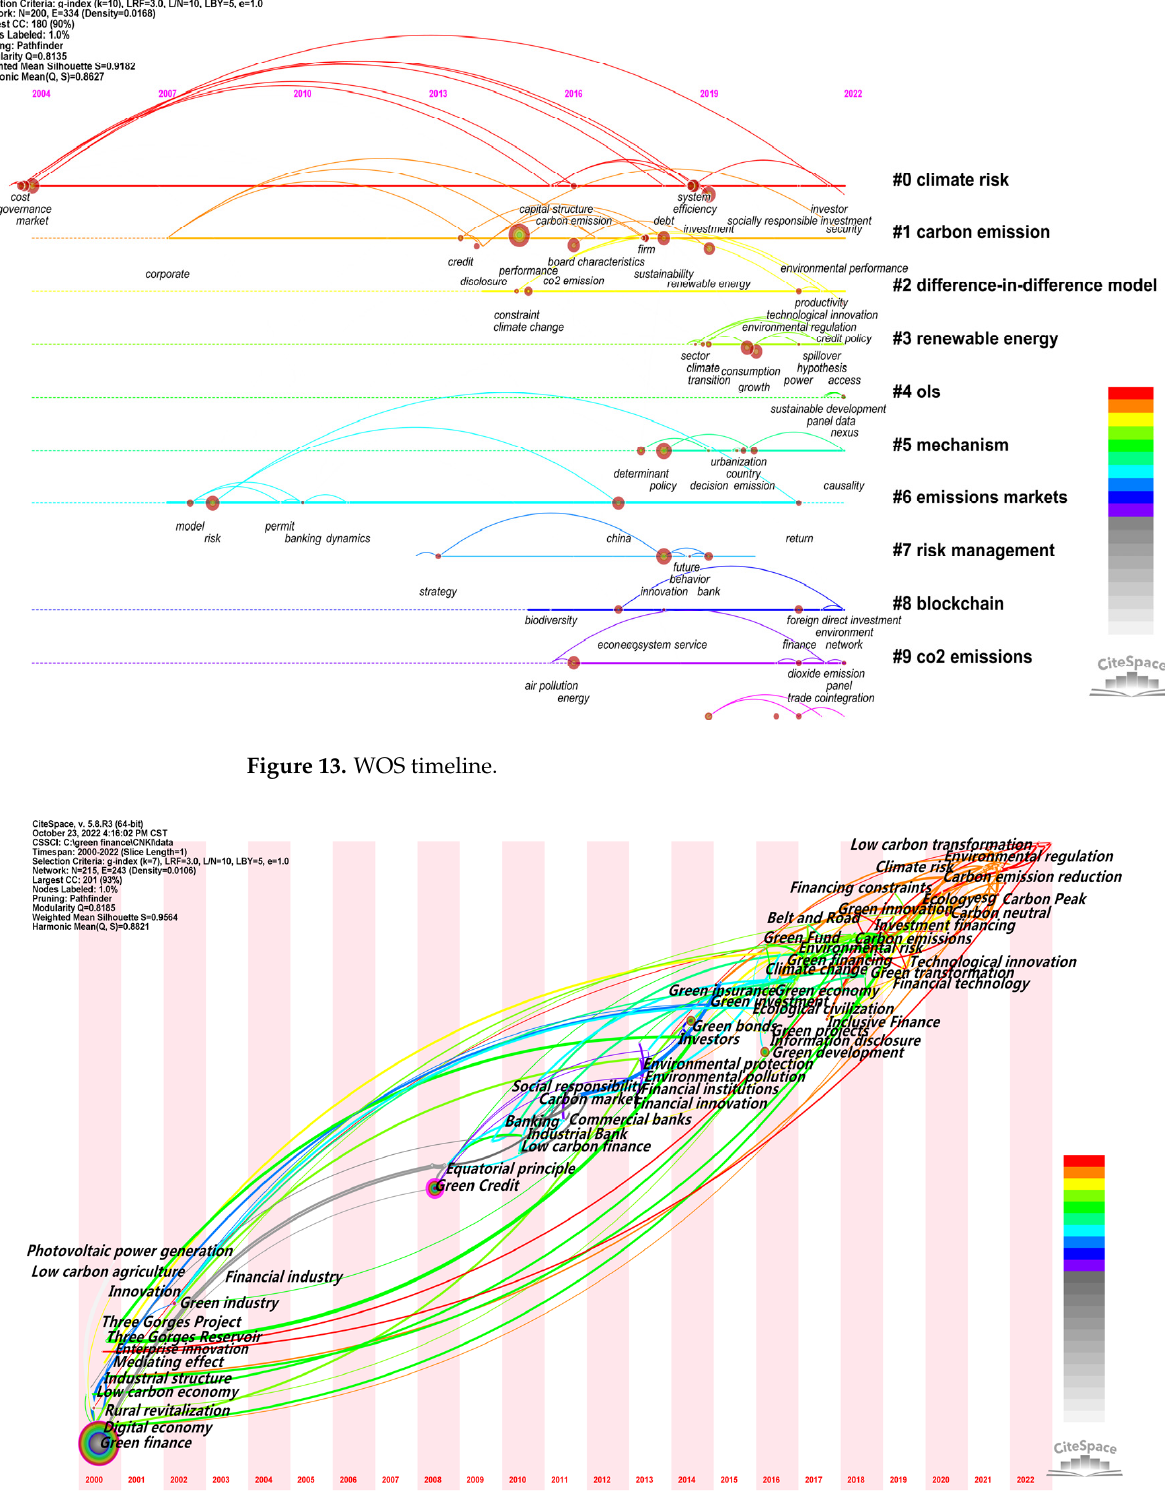
Figure 14. CNKI time zone chart.